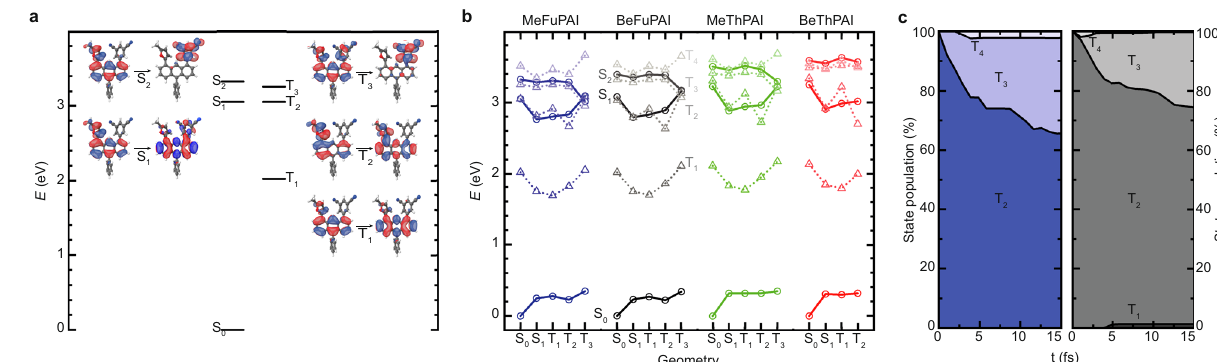
Fig. 4 Simulation results. a Energy diagram of MeFuPAI at the S 0 geometry and corresponding NTOs depicting hole and electron, allowing a differentiation into LE and CT states. b Visualization of singlet (circles) and triplet (triangles) energy levels (in order of decreasing contrast S 0 , S 1 , S 2 , T 1 , T 2 , T 3 , and T 4 ) for all four fl uorophores at the geometries of their respective S 0 , S 1 , T 1 , T 2 , and T 3 states. Except for BeThPAI, where T 3 is a LE state and the CT state could not be optimized. The connective line represents a guide to the eye. c FOMO-CASCI dynamics of the state population distribution between T 1 , T 2 , T 3 , and T 4 , upon “ electrical ” excitation into the T 2 state for MeFuPAI (left) and BeFuPAI (right).